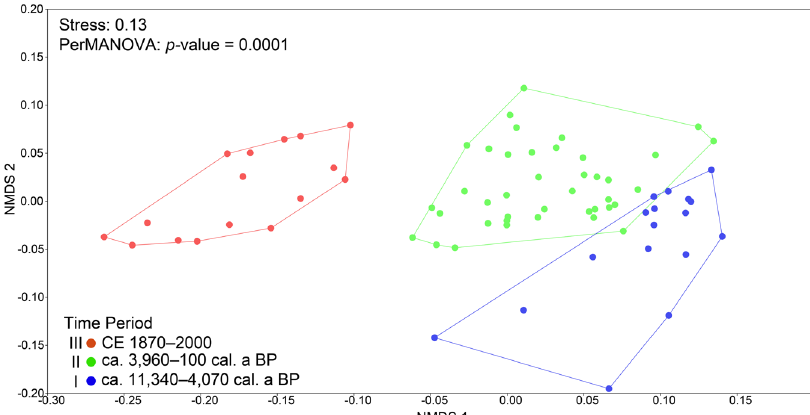
Fig. 4 Cyanobacteria Holocene beta-diversity analysis based on amplicon data. A non-metric multidimensional scaling (NMDS) visualisation of cyanobacteria community beta diversity based on amplicon sequence data using Bray – Curtis dissimilarity. The dots represent the sample depths analysed.